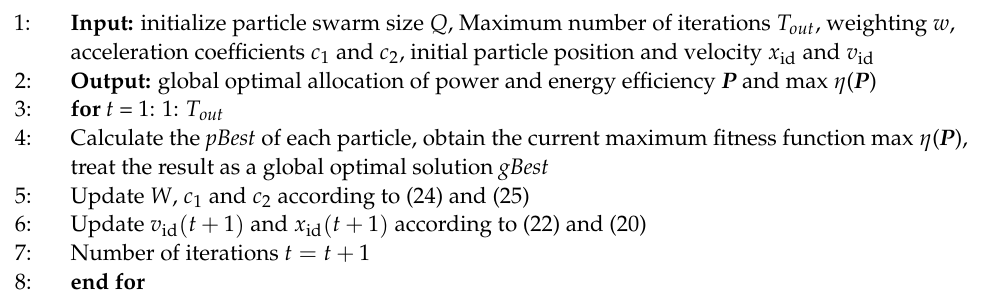
Algorithm 2 Improved PSO-Based Power Allocation